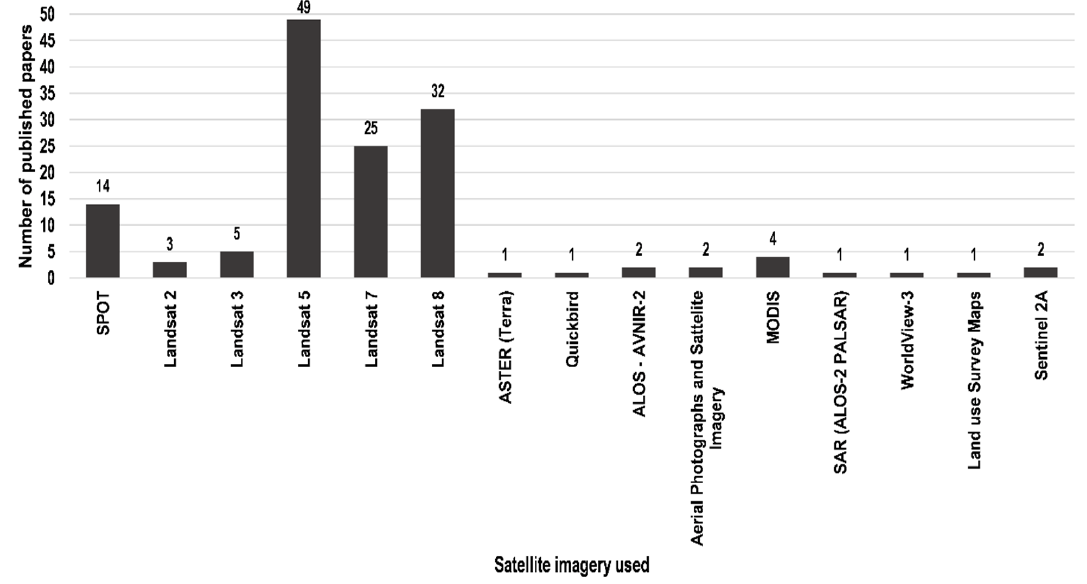
Figure 7. Frequency of satellite imageries used by the researchers in Pakistan for forest mapping.